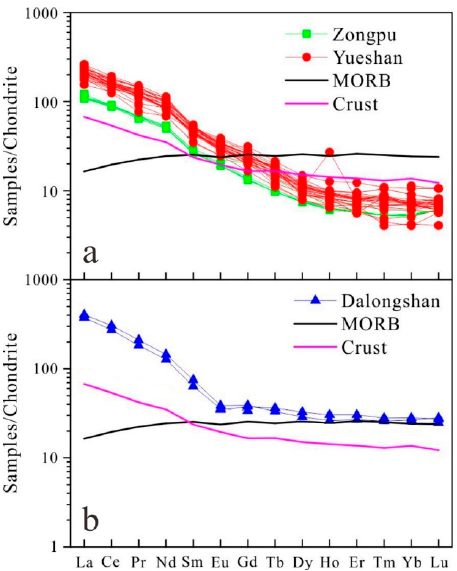
Figure 6. Chondrite normalized REE patterns of diorites ( a ) and granites ( b ) from the Anqing orefield. Chondrite, MORB and continental crust are taken from [55,57,58], respectively.